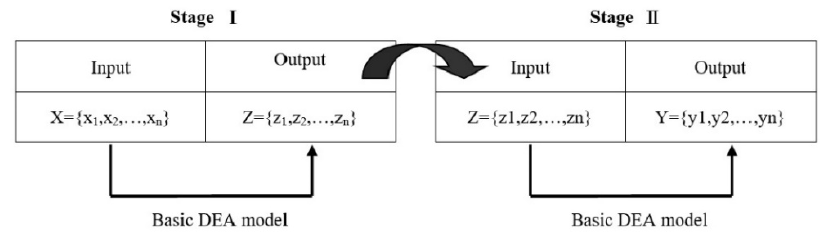
Figure 2. A two-stage DEA model.